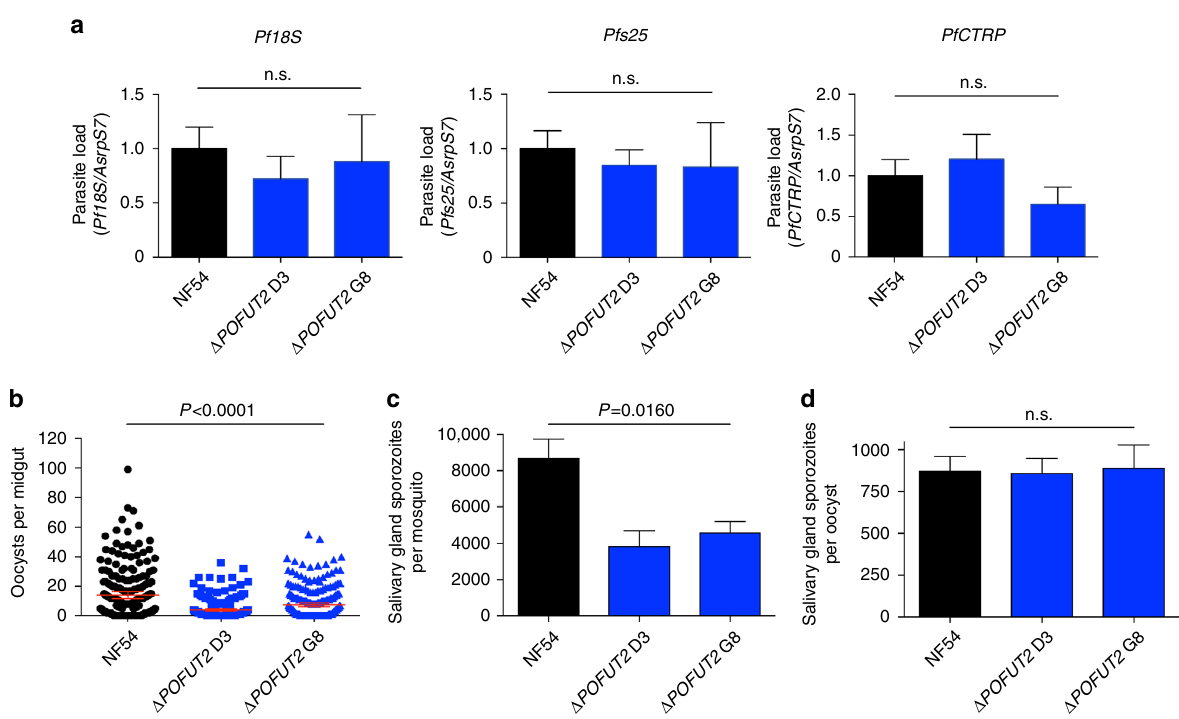
Fig. 2 POFUT2 is important for P. falciparum transmission to Anopheles stephensi mosquitoes. a Parasite load in mosquito midguts 27 h post-bloodmeal, measured by qRT-PCR of transcripts for Pf18S (total parasites) , Pfs25 (gametes, zygotes, ookinetes), and PfCTRP (ookinetes) relative to Anopheles stephensi ribosomal protein, rps7 (AsrpS7). No signi fi cant differences were observed relative to NF54 for Pf18S ( P = 0.4973), Pfs25 ( P = 0.3513), and PfCTRP ( P = 0.2547). b Oocyst counts per mosquito midgut 7 days post-bloodmeal. Data are mean ± 95% con fi dence interval from three independent experiments. c Salivary gland sporozoite count per mosquito 17 days post-bloodmeal. d Salivary gland sporozoite count divided by oocyst count ( P = 0.9945). Data is the mean ± S.E.M. from three independent experiments. P -values are for both mutant clones compared to NF54, calculated using the Kruskal – Wallis one-way